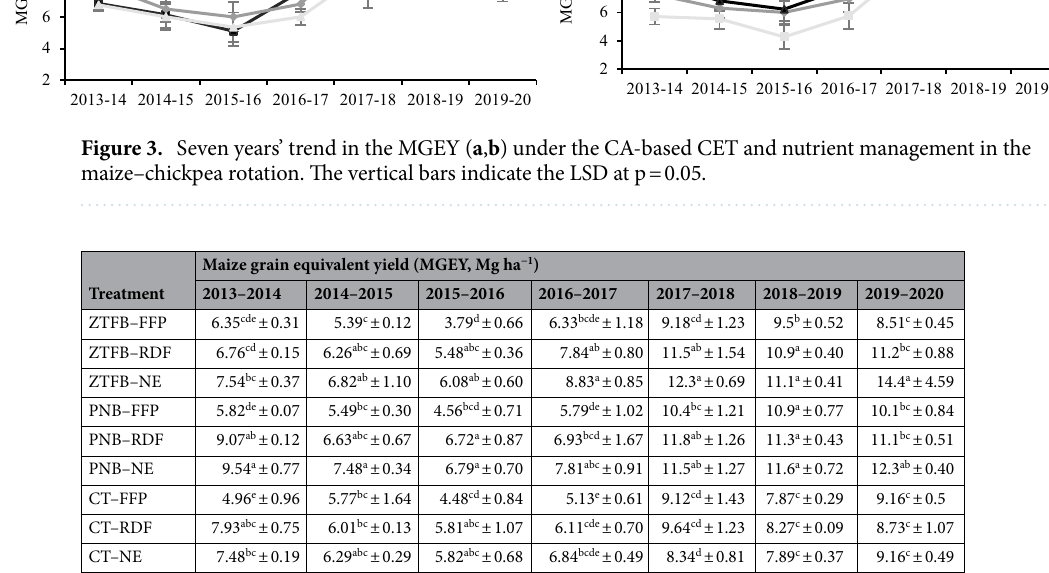
highest MGEY, and significantly greater than the ZTFB–FFP and CT (Table 2). The results of the current study also suggested that the NE and RDF either with the PNB or ZTFB tended to have relatively more MGEY than the with CT.